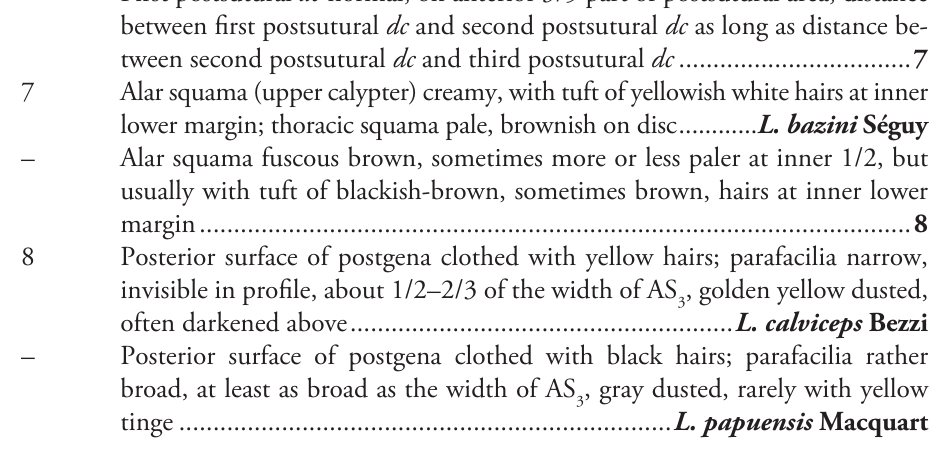
Fifth tergite without discal bristles; hind tibia never fringed in male ........... 3 Fifth tergite with 1 pair of discal bristles; hind tibia more or less fringed in male, sometimes not very dense, covered with row of 3–7 fine long anter- oventral bristles ( av ) on apical 1/2 .............................................................. 6 Vibrissa far above oral margin, distance between vibrissa and oral margin larger than wide of AS ; clypeus strongly projecting forward; posterior margin of eye 3 somewhat concave at middle; fore tibia in male with 5+2 ventral spines; hairs on pteropleuron wholly yellowish (Fig. 1) .................. B. torosa (Wiedemann) – Vibrissa level with oral margin; clypeus less strongly projecting; posterior margin of eye straight, not concave at middle; fore tibia in male with 3 ventral spines; hairs on pteropleuron wholly whitish yellow or with some black hairs Epaulet (tegula) blackish, with hind margin yellowish; pteropleuron hairs